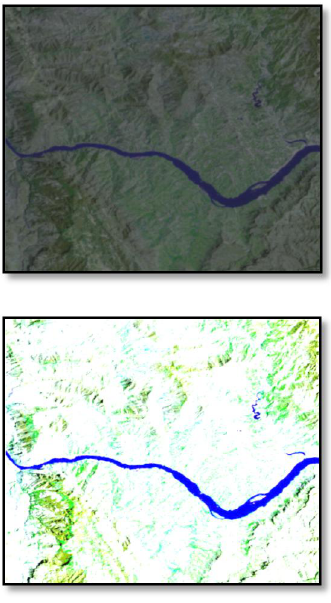
Figure 1. Remote image of different intensity (clear surface, too dark and black , too bright and saturated )